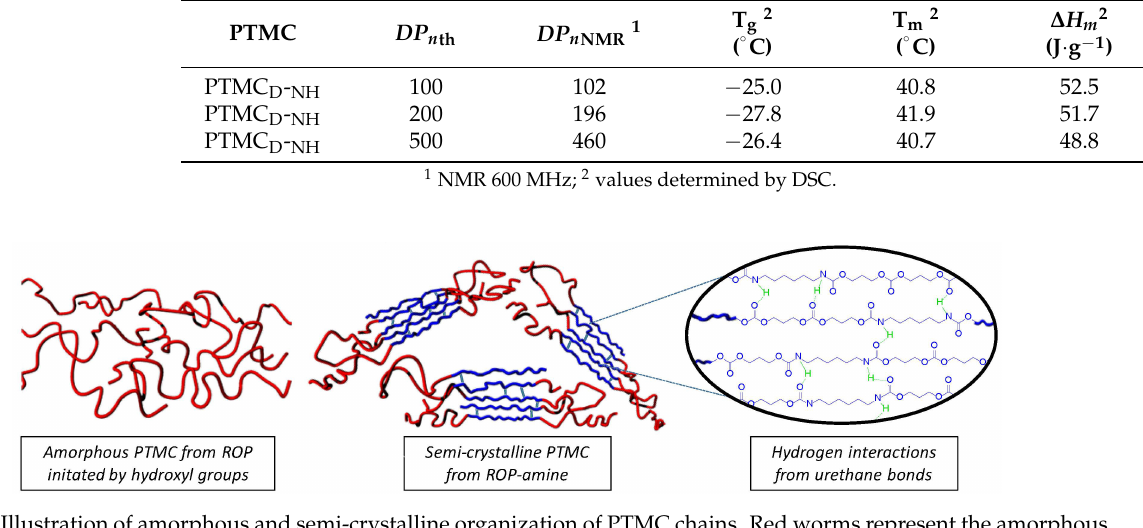
Figure 7. Illustration of amorphous and semi-crystalline organization of PTMC chains. Red worms represent the amorphous phase while blue worms illustrate the crystalline phase.